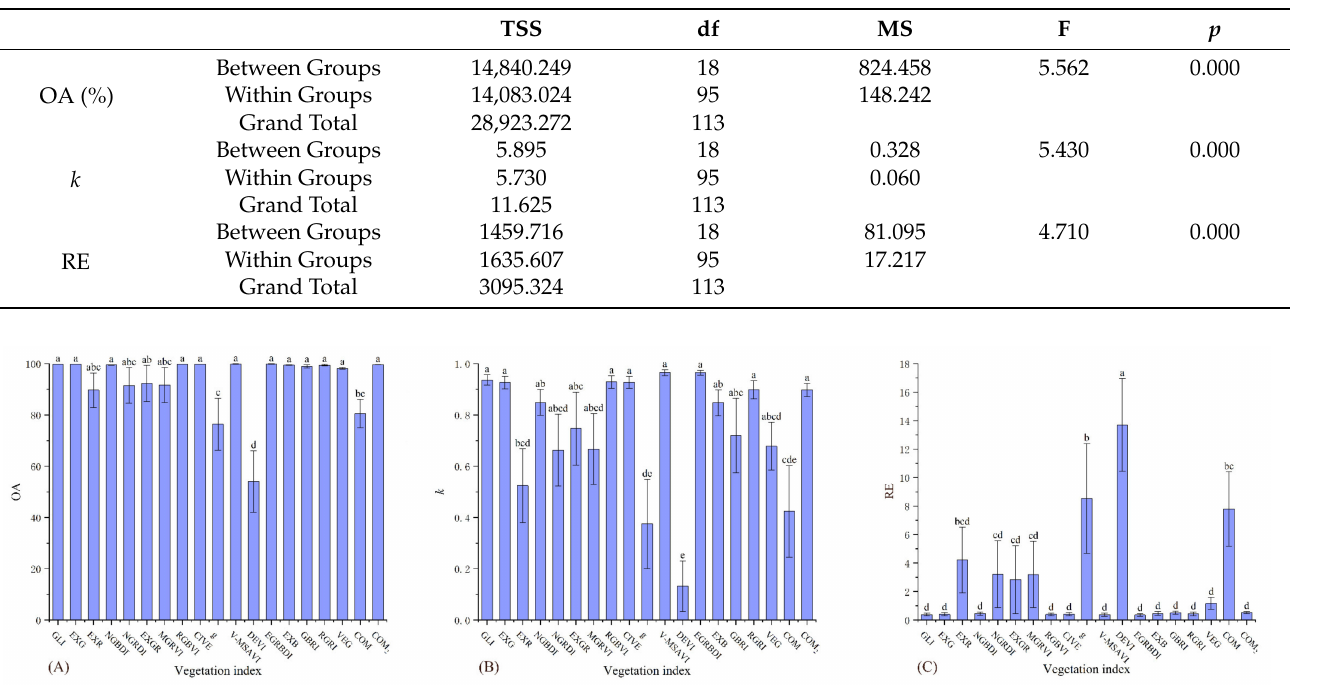
Figure 2. OA, k , and RE differences of 19 vegetation indices on the severe desertification grade. ( A ) figure is the result of one-way analysis of variance for OA. ( B ) figure is the result of one-way analysis of variance for k . ( C ) figure is the result of one-way analysis of variance for RE. Values with the same lowercase letters within vegetation indices are not significantly different at p <